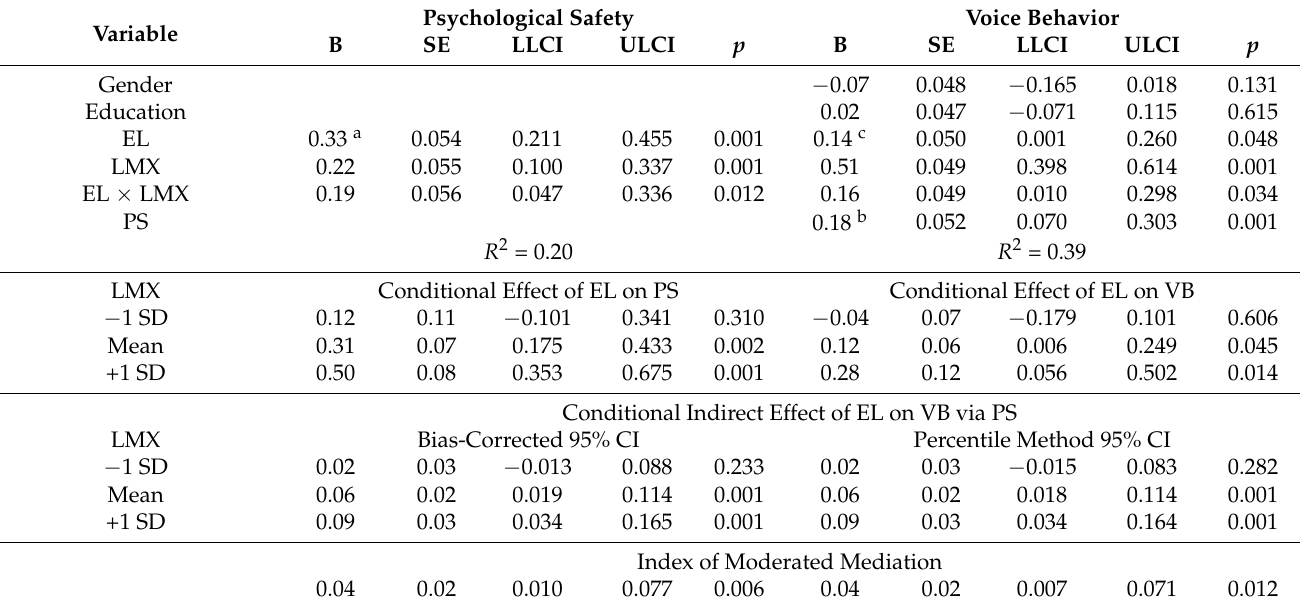
Table 5. Moderated-mediation